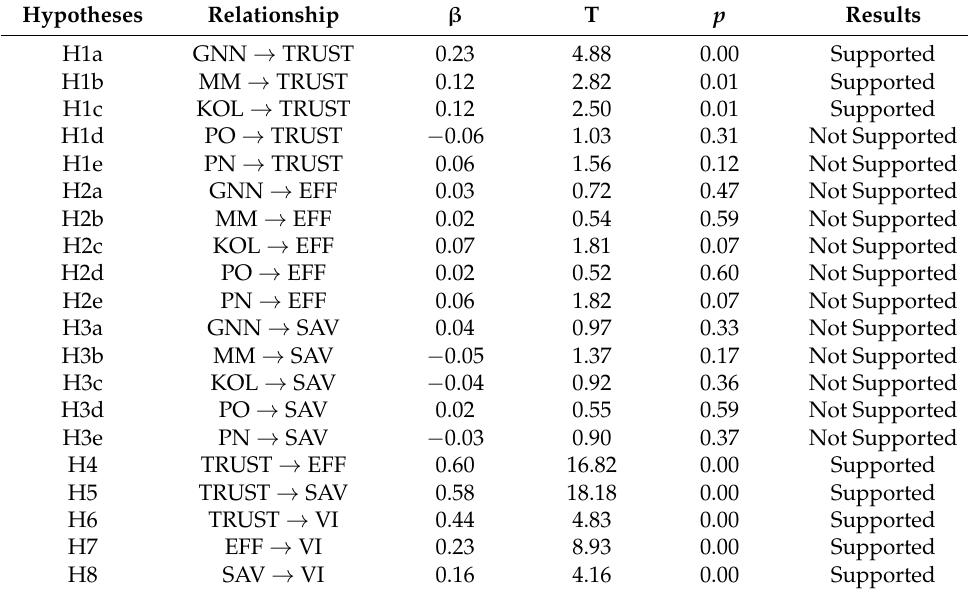
Table 5. Results of hypothesis